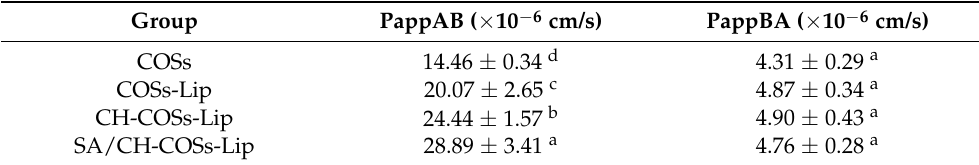
Table 2. Apparent permeability coefficient of two-way transport of COSs and different